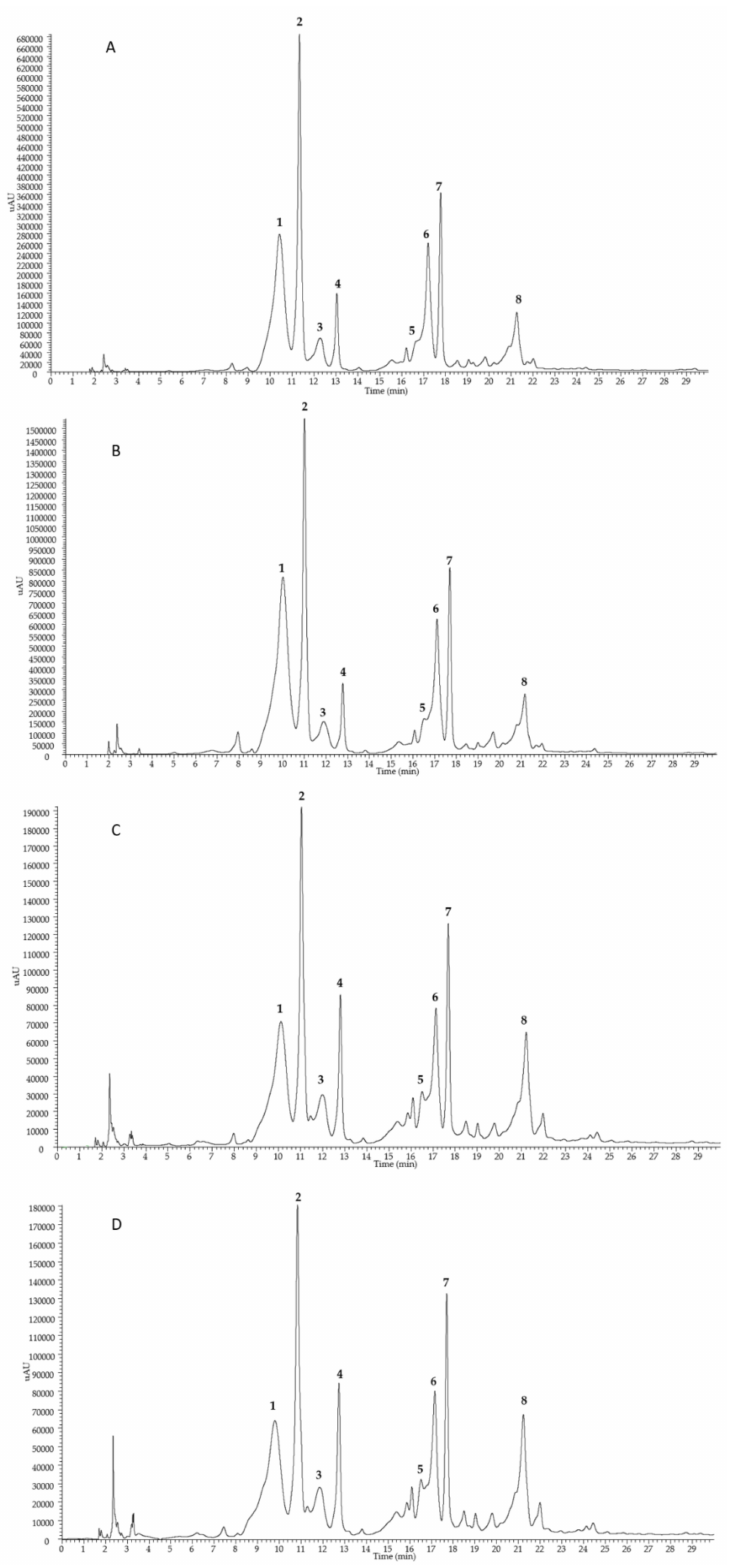
Figure 3. HPLC–PDA/UV profiles (detected at 280 nm) of secoisolariciresinol diglucoside (SDG) oligomers alkaline hydrolysates from the defatted seed meal extracts of flaxseed Sideral cultivated in Bologna ( A ) and Pisa ( B ), and Buenos Aires cultivated in Bologna ( C ) and Pisa ( D ). For peak data, see Table